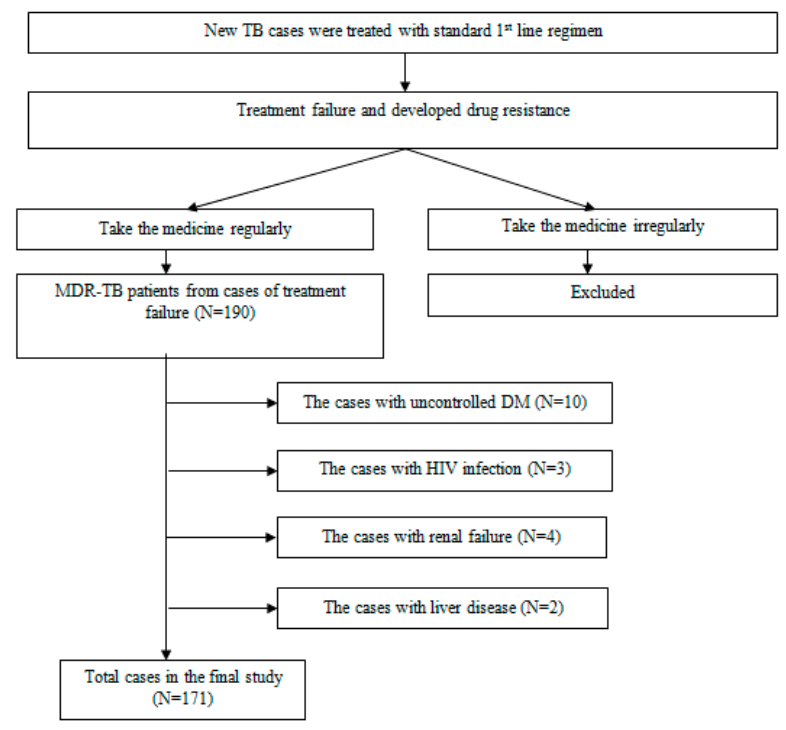
Figure 1. Flow chart of the Inclusion Study Subjects.